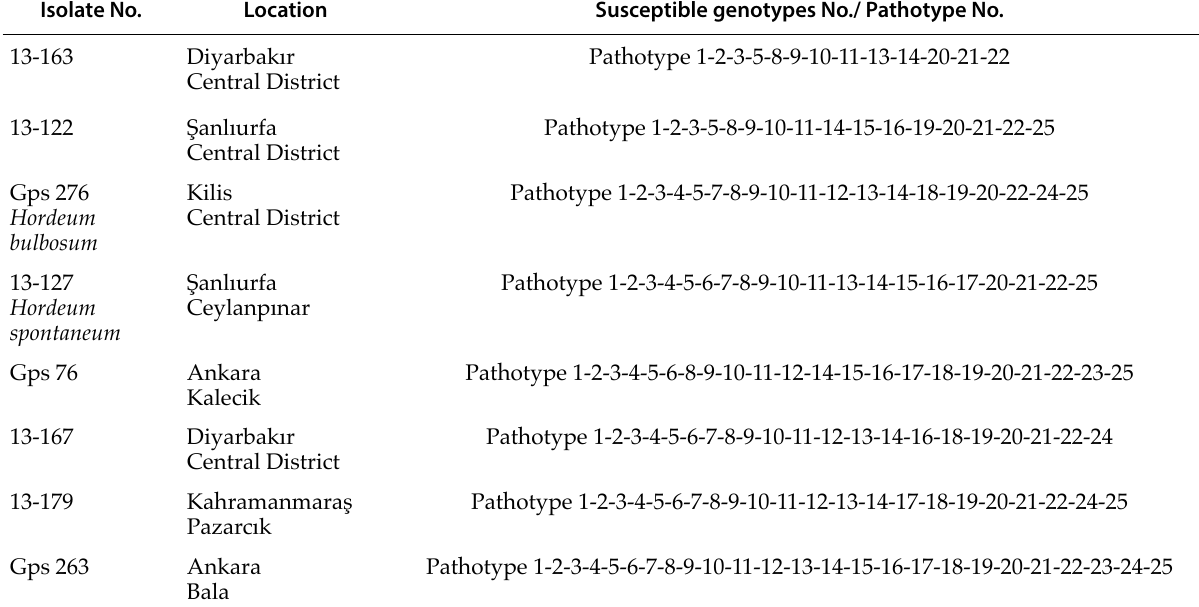
Table 1. Isolate No. Location Susceptible genotypes No./ Pathotype No.